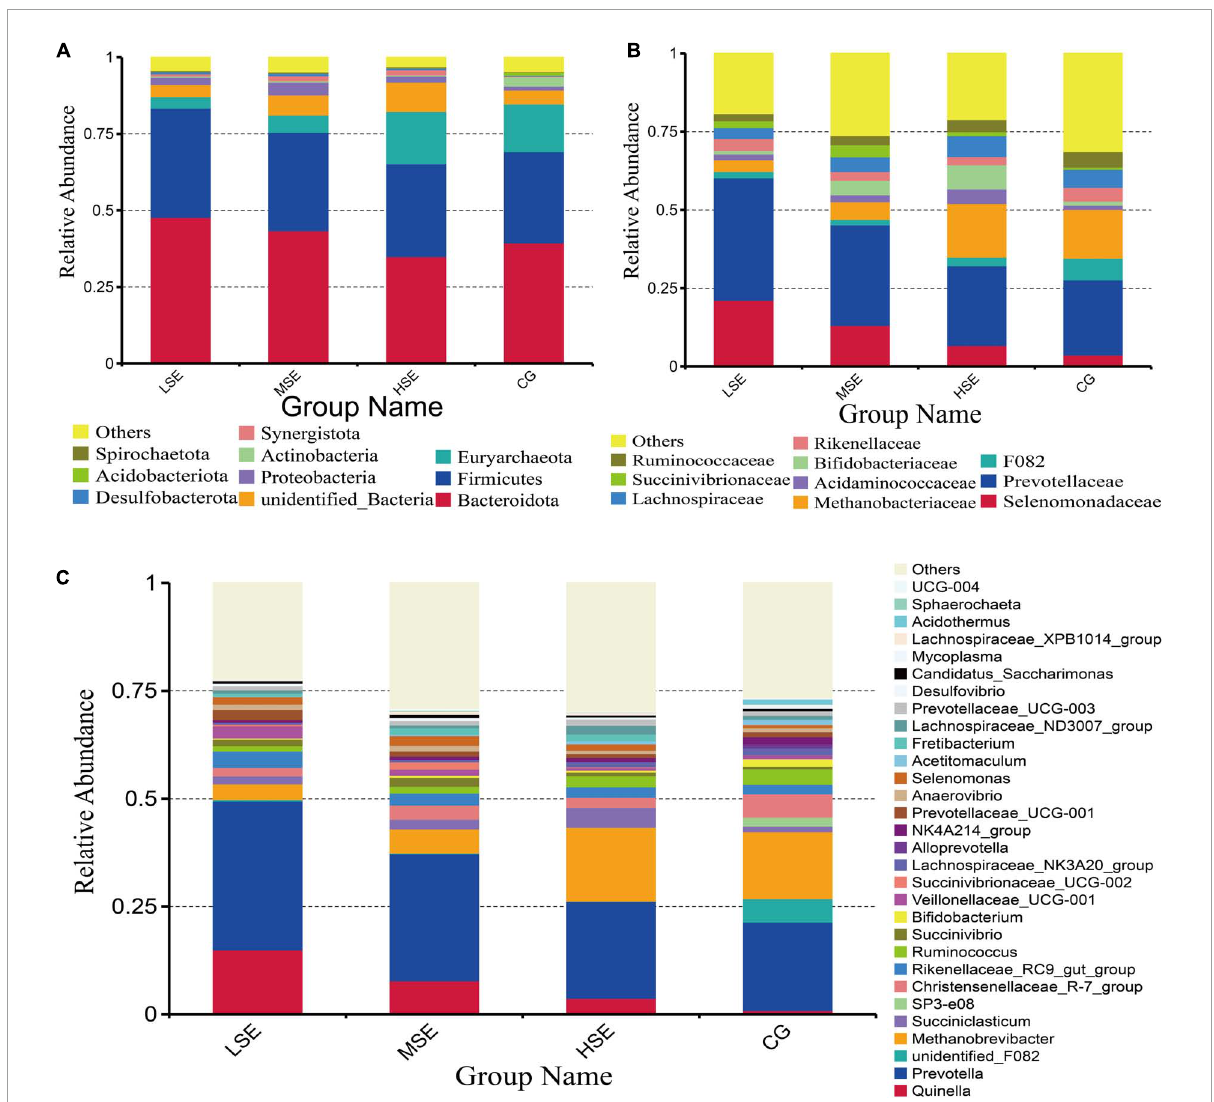
FIGURE3 Rumen bacterial compositional profiles of different SeHLan supplemented groups. Relative abundance of bacterial taxa averaged under phylum level (A) , family level (B) , and genera level (C) . The color-coded bar plot shows the average bacterial phylum, family, and genus distributions level of the different diets sampled. CG, control group; LSE, low Se group; MSE, medium Se group; HSE, high Se